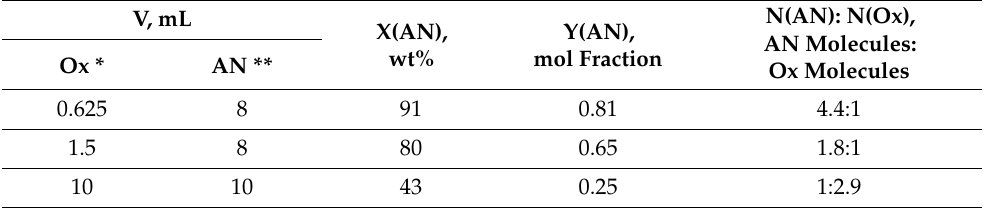
Table 2. The ratio of the main components of water-acetonitrile solutions of three reaction mixtures. V,